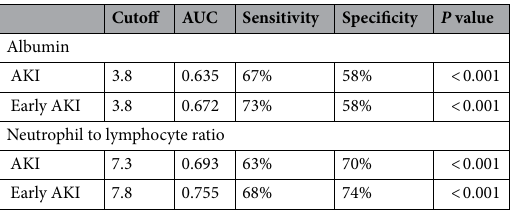
Table 6. Data from receiver operating characteristic curves for albumin and the neutrophil to lymphocyte ratio for predicting acute kidney injury. AKI: acute kidney injury, AUC: area under the